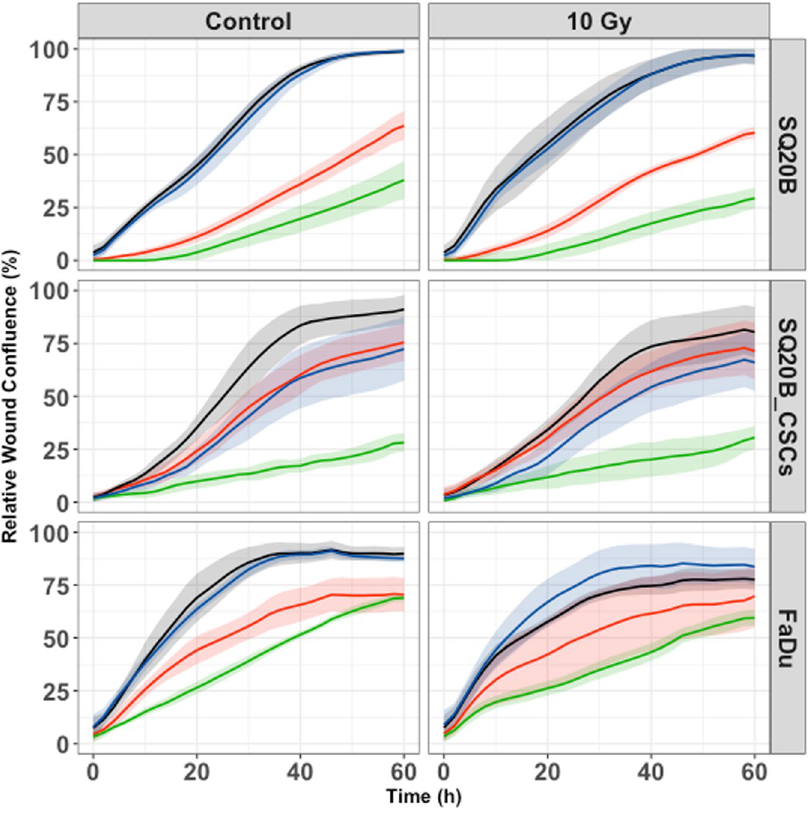
Figure 3. Cell migration under each treatment condition, graphically represented by the mean migration curves + / − standard deviation. Blue curve, control; black curve, pertuzumab 20 μ g/mL; red curve, cetuximab 5 nM; green curve, cetuximab 5 nM + pertuzumab 20 μ g/mL. Cell migration was measured by an IncuCyte Zoom scratch wound analyser for each cell line under the following treatment conditions: control; cetuximab 5 nM; pertuzumab 20 μ g/mL; cetuximab 5 nM + pertuzumab 20 μ g/mL; 10 Gy; 10 Gy + cetuximab 5 nM; 10 Gy + pertuzumab 20 μ g/mL; 10 Gy + cetuximab 5 nM + pertuzumab 20 μ g/mL. Each experiment was performed in